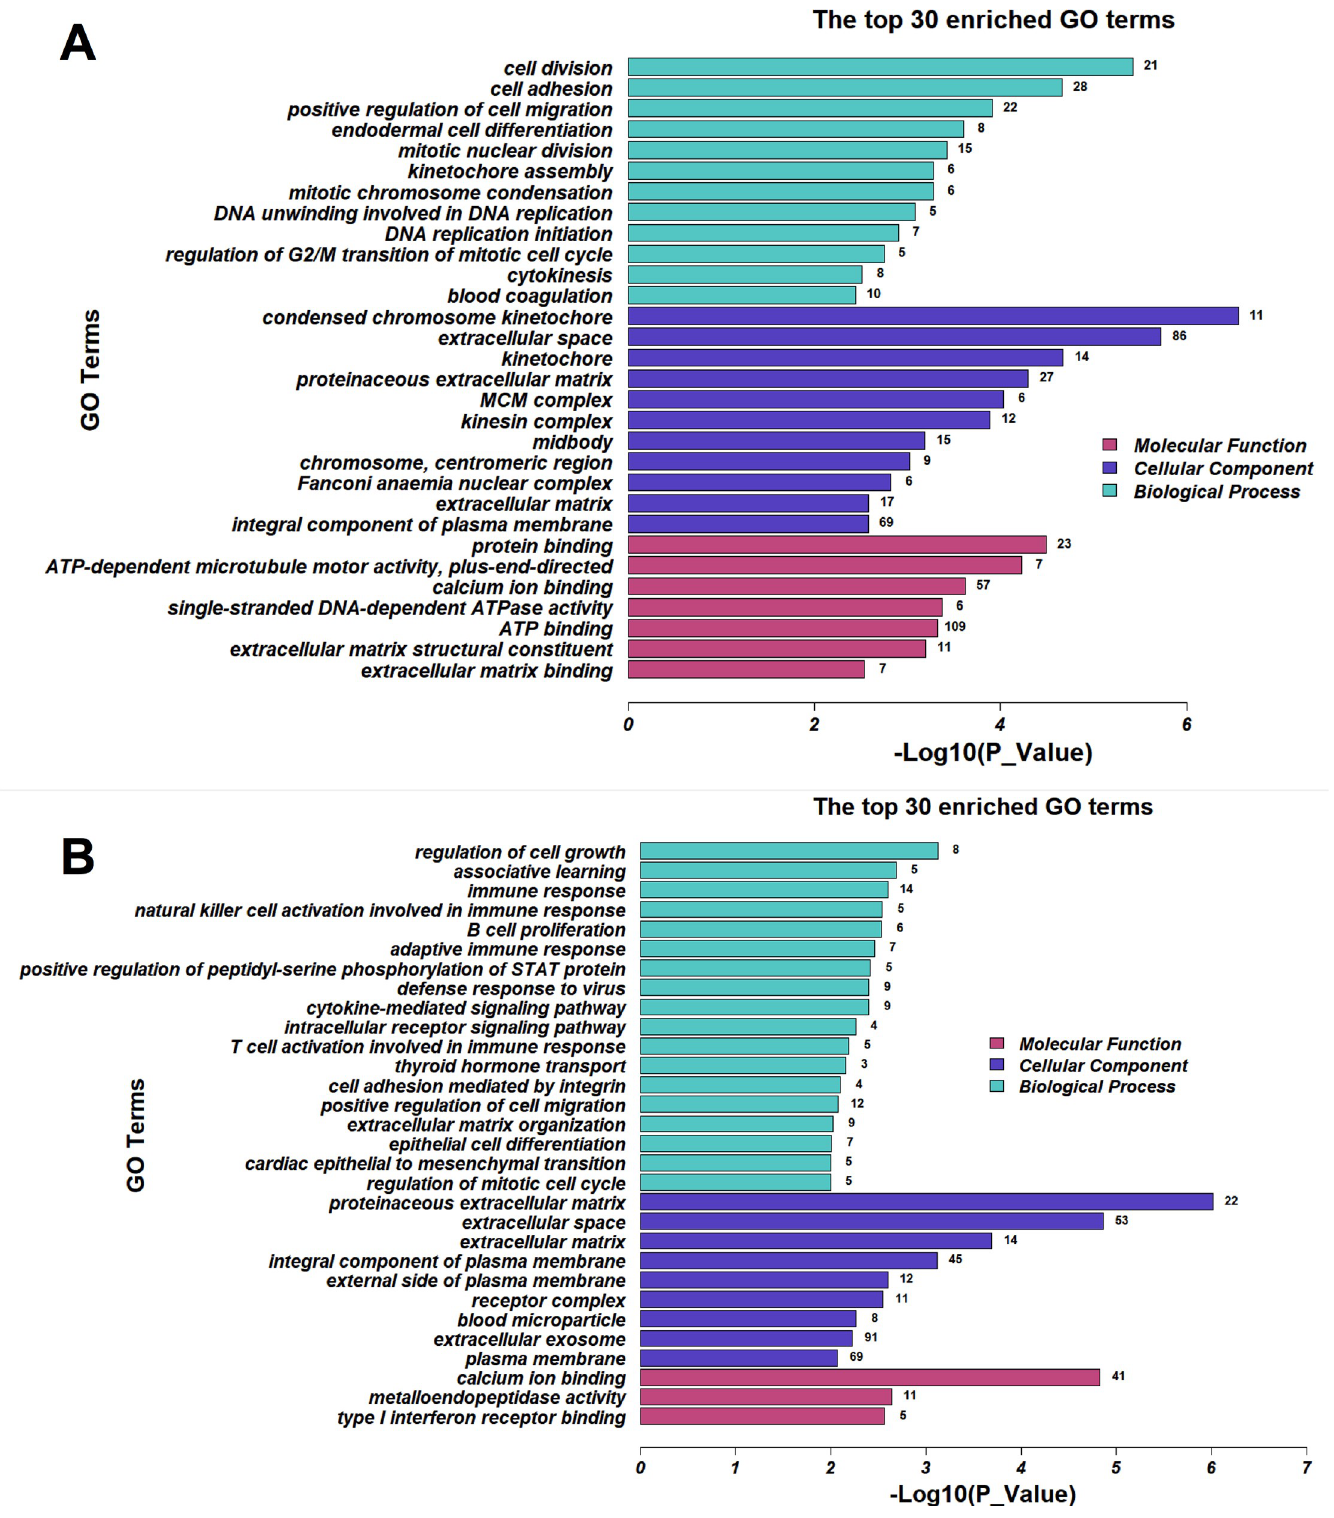
Fig 4. The most enriched Gene Ontology (GO) terms associated with the DEGs in the chicken granulosa cells induced by FOXL2 silencing. (A) GO terms of DEGs in the comp. poGC; (B) GO terms of DEGs in the comp. phGC. The red, violet and blue bars represent the terms of molecular function, cellular component and biological process,